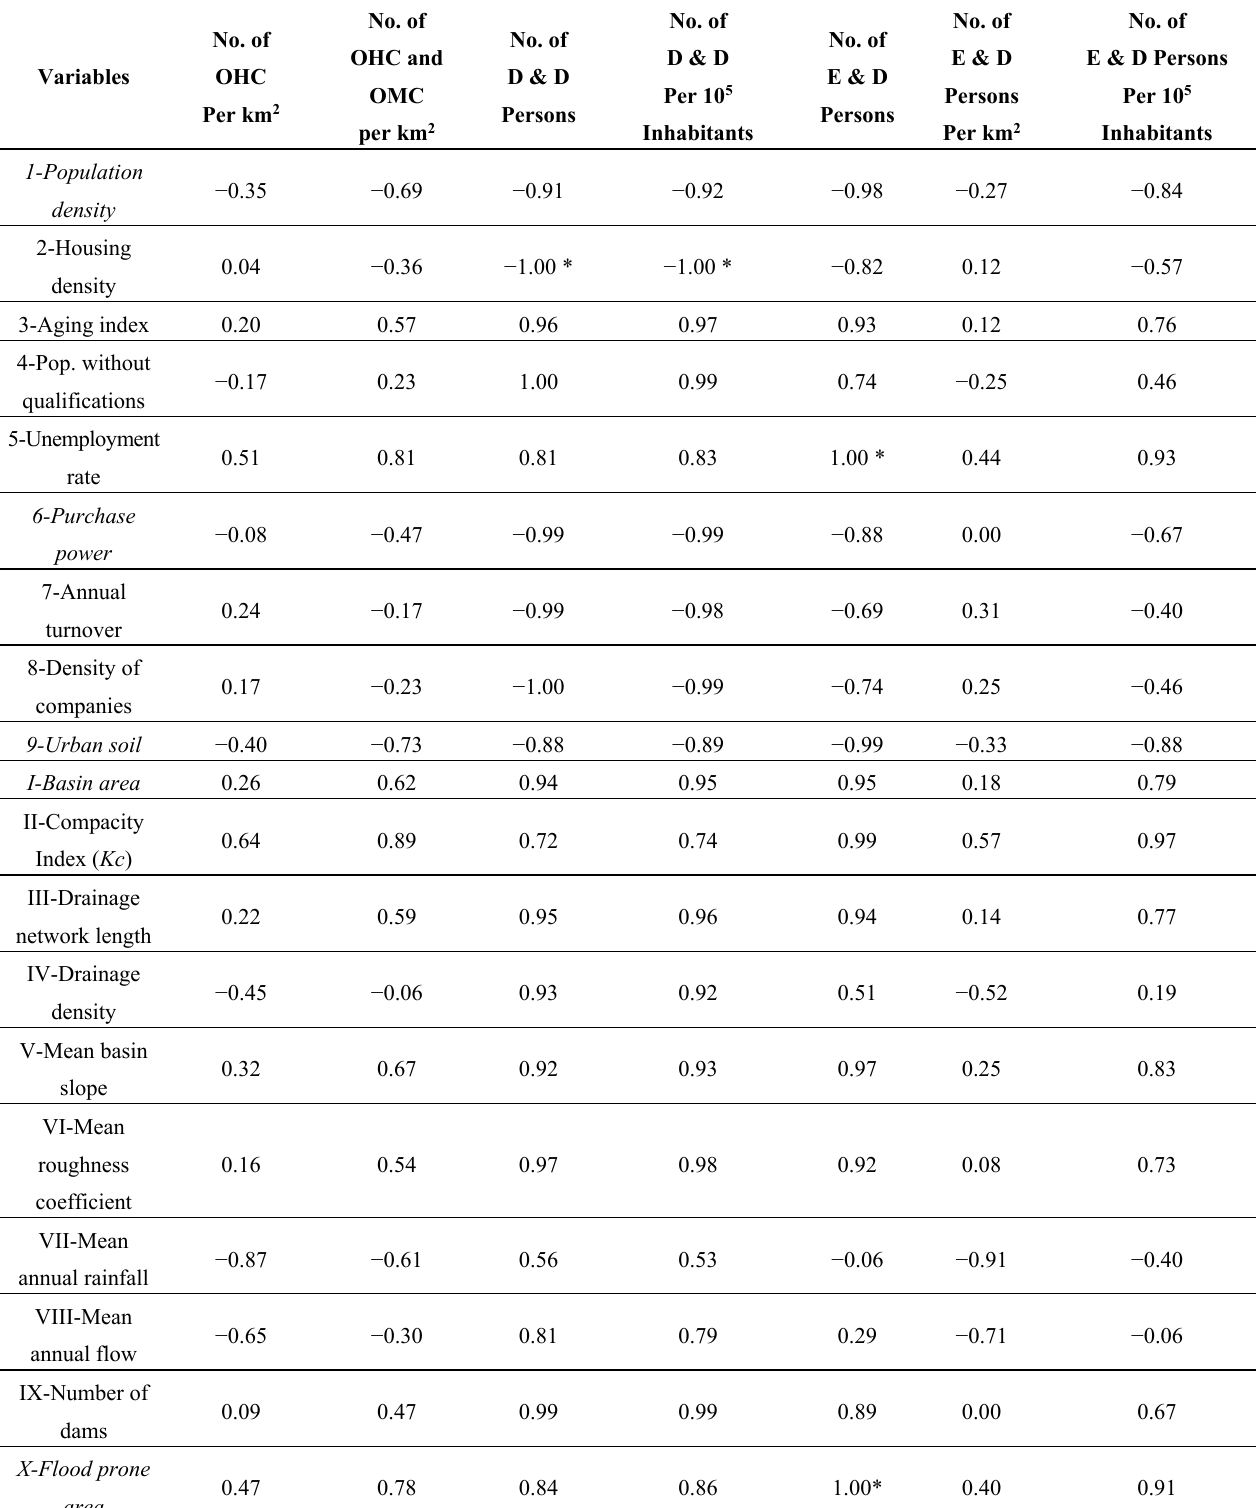
Table 7. Pearson correlation matrix between territorial forcers and impact